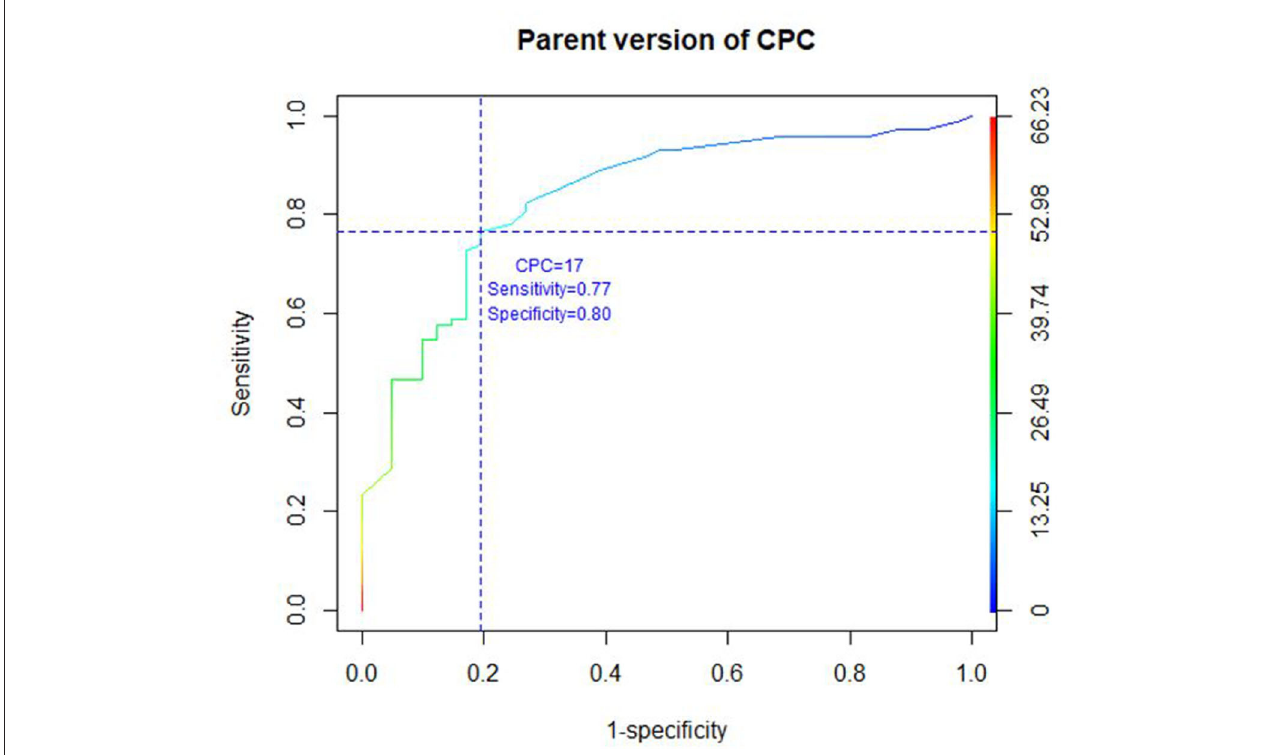
FIGURE 2 | ROC CURVE parent version of CPC. score for girls (mean = 0.8, SD = 1.3 vs. mean = 0.4, SD = 0.9, p =